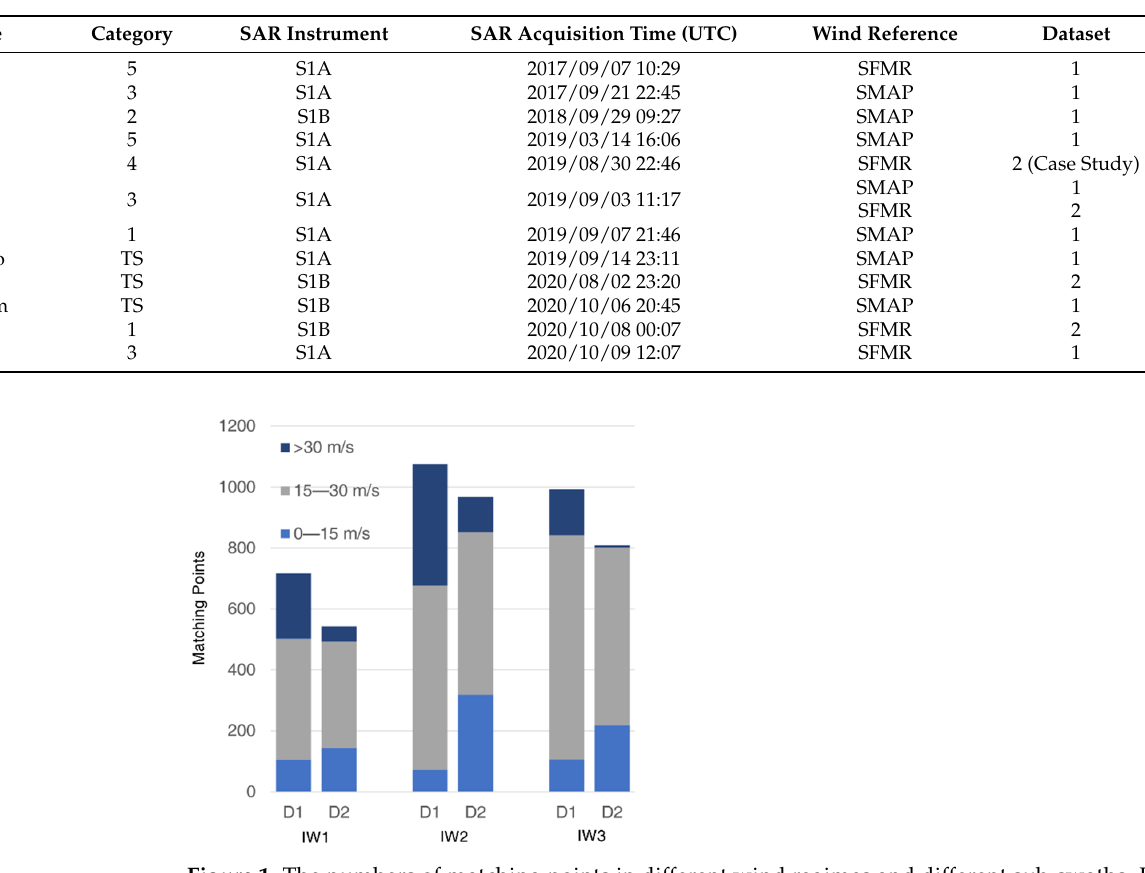
Table 1. Information of TCs, SAR images, and wind references.